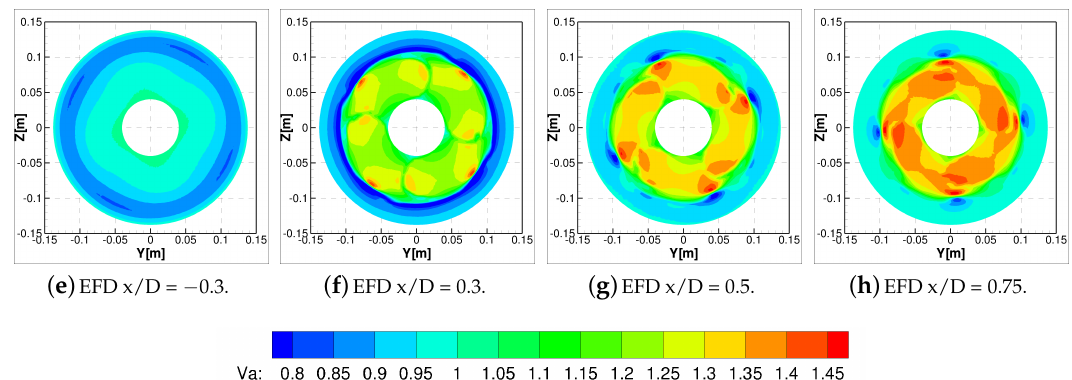
Figure 14. Axial non-dimensional velocity at different transversal sections for the ducted configuration.